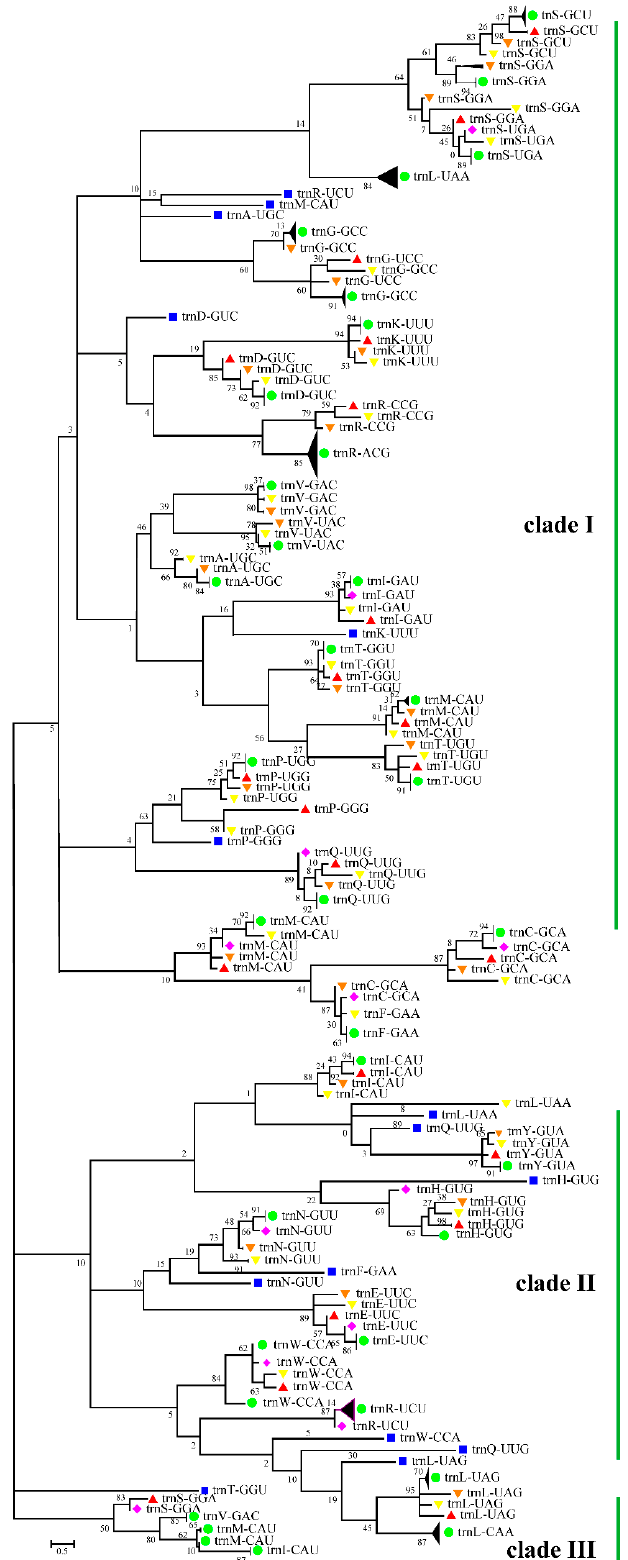
Figure 5. Phylogenetic tree of chloroplast tRNAs. A, alanine (Ala); R, arginine (Arg); N, asparagine